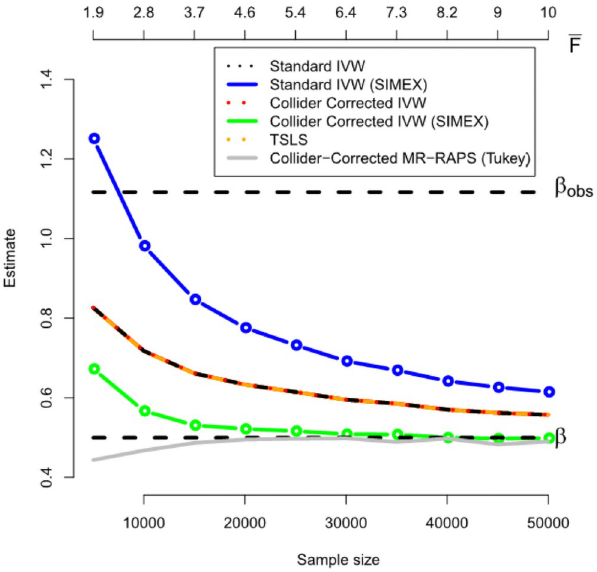
Fig 4. Performance of IVW implementations (including the Collider-Correction algorithm) using one-sample data.